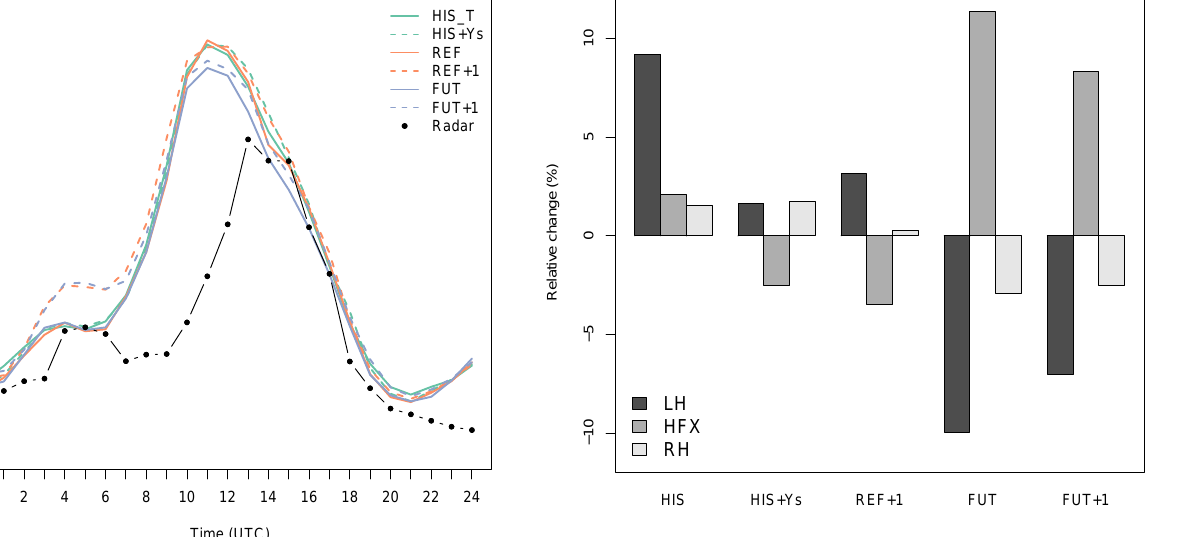
Figure 10. Mean relative change (%) over the Netherlands in latent heat flux (LH), sensible heat flux (HFX), and relative humidity (RH) in each of the experiments in comparison to